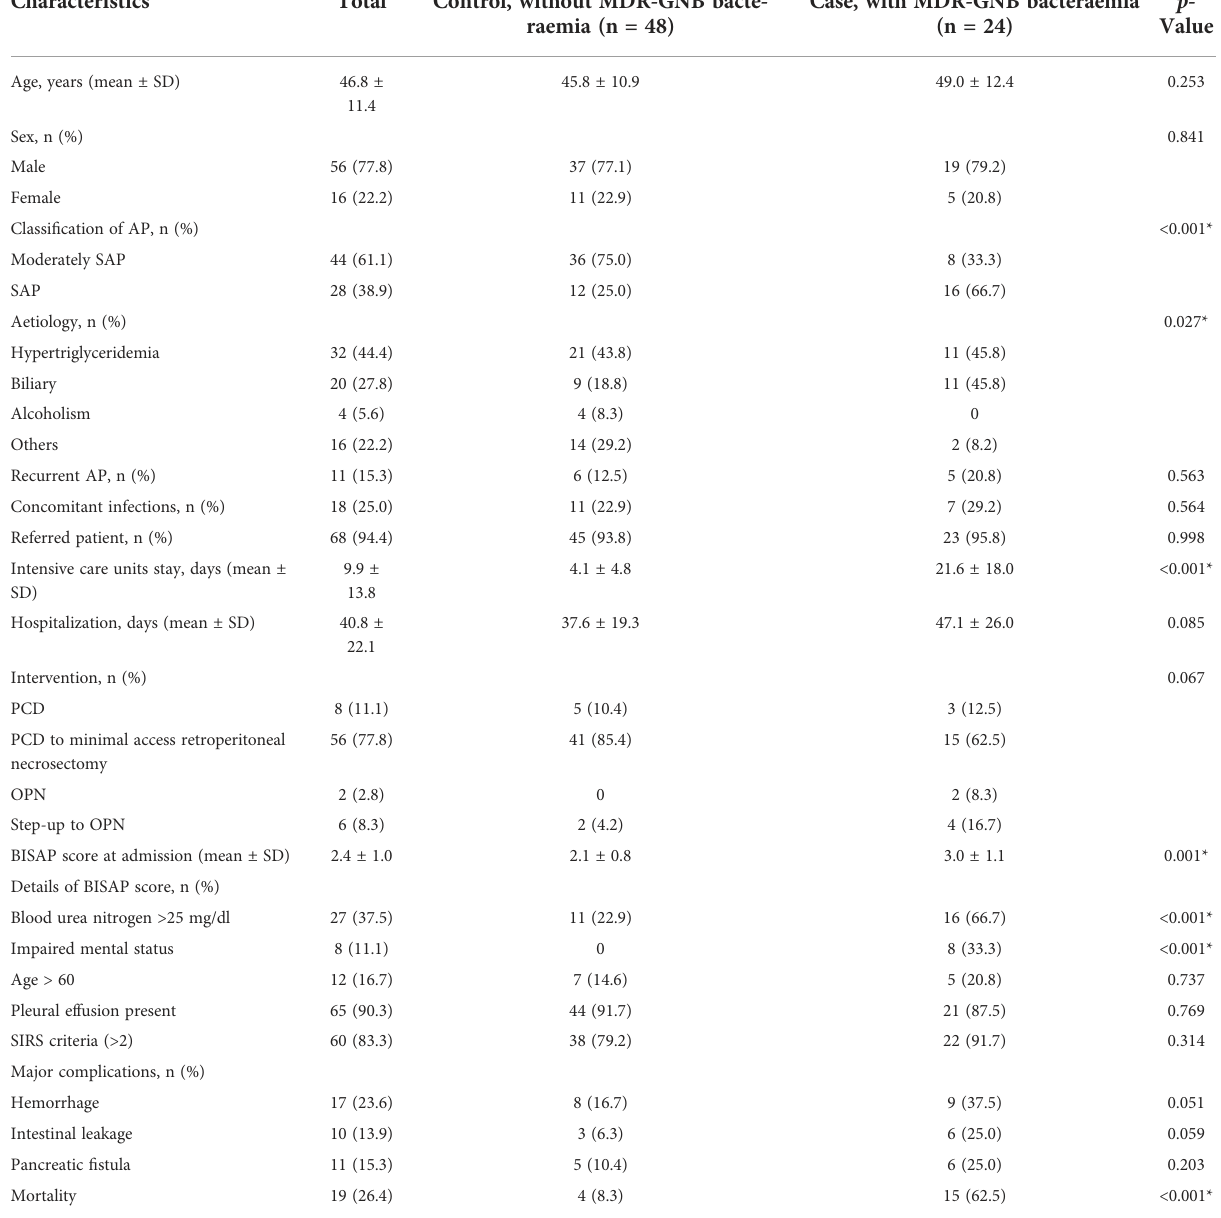
TABLE 1 Clinical characteristics and comparison between IPN patients with and without MDR-GNB bacteraemia.